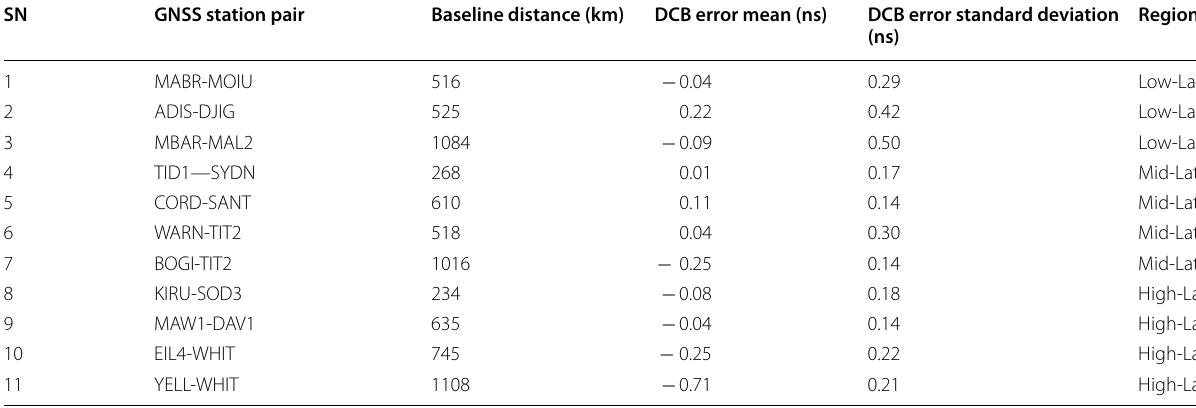
Table 1 Pair of GNSS stations used to evaluate the technique. In the stations’ pair, in the first column, the first station code is the code of the uncalibrated station, and the second code is for the